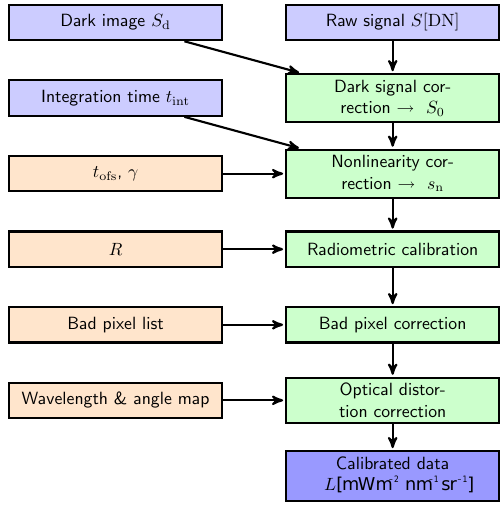
Figure 5. Schematic calibration using the newly developed nonlin- earity correction. Light blue boxes are measured data, orange boxes are characterization data, green boxes are calibration steps, and dark blue is the calibrated